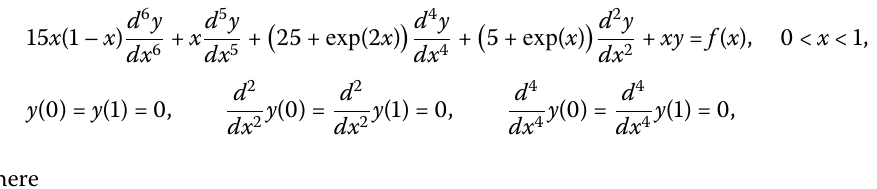
Figure 4 Graph of the exact solution y ( x ) = exp( x ) versus the approximate solution in fourth-order uniform mesh method for N = 32 and σ = 1 for Example